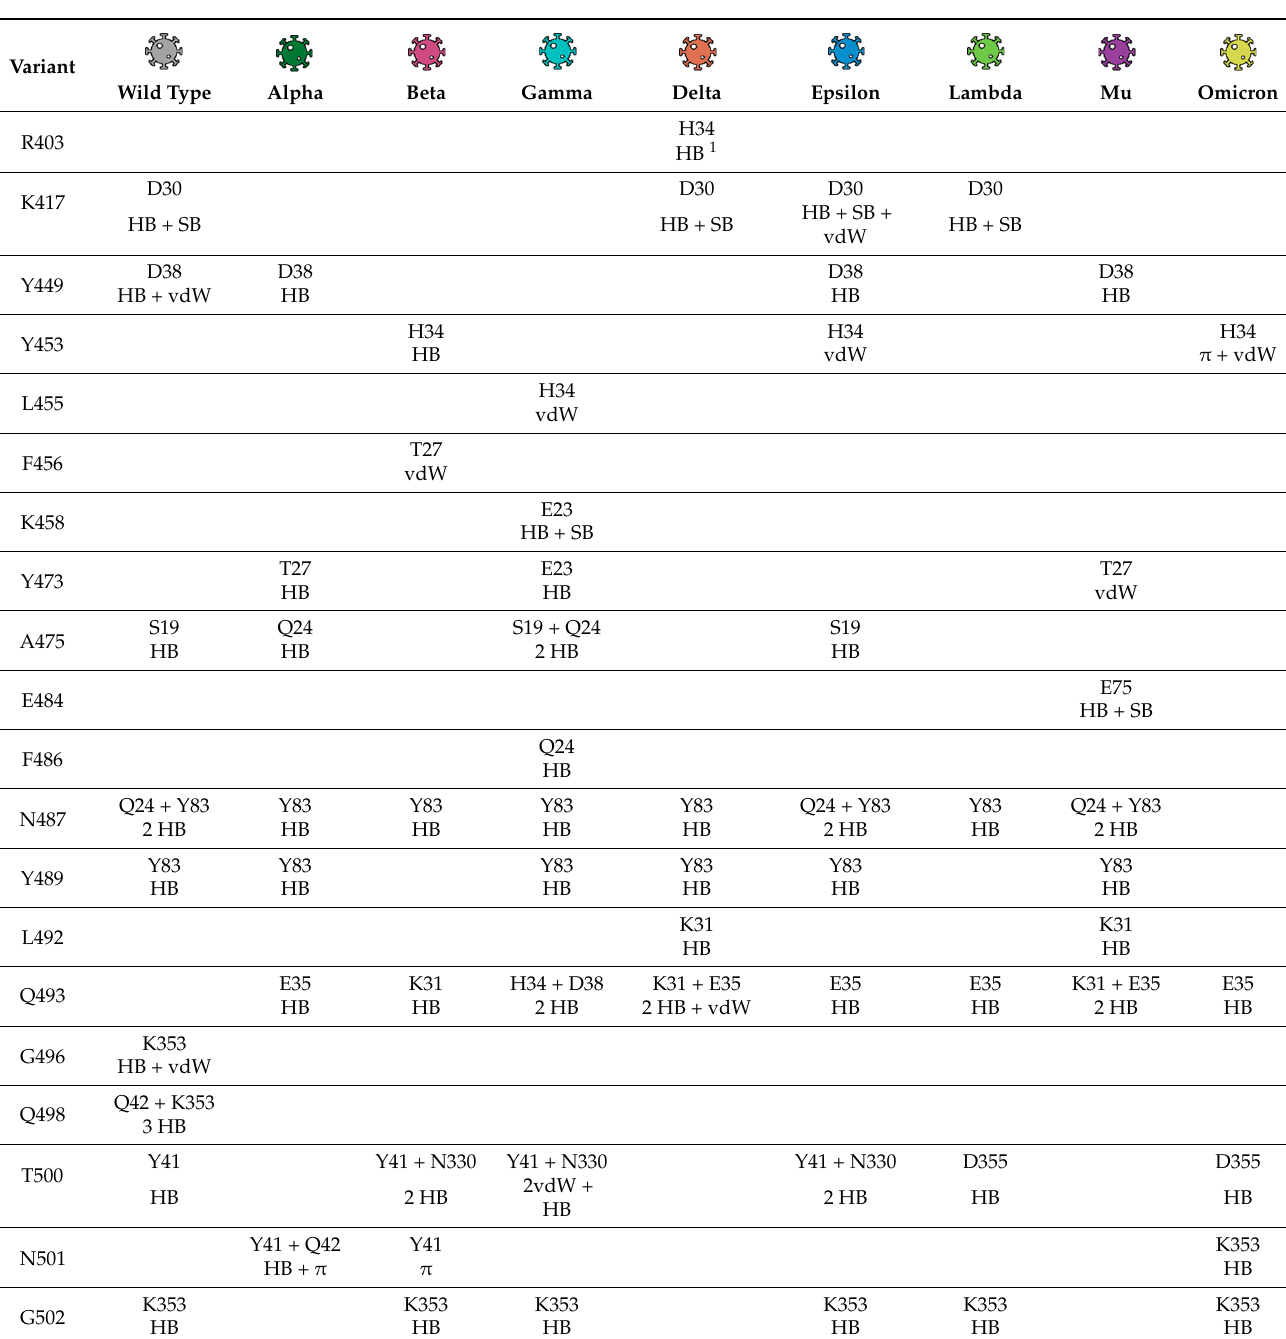
Table 1. Interaction between RBDs and ACE2 as a result of MD trajectory clustering.